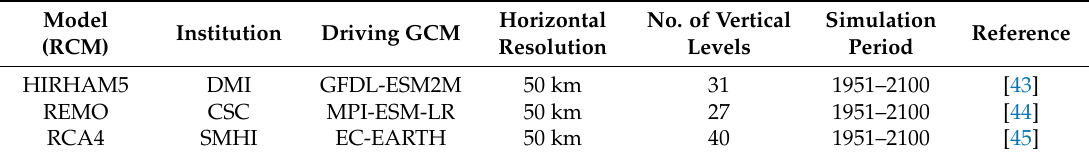
Table 2. Main characteristics of the RCMs.